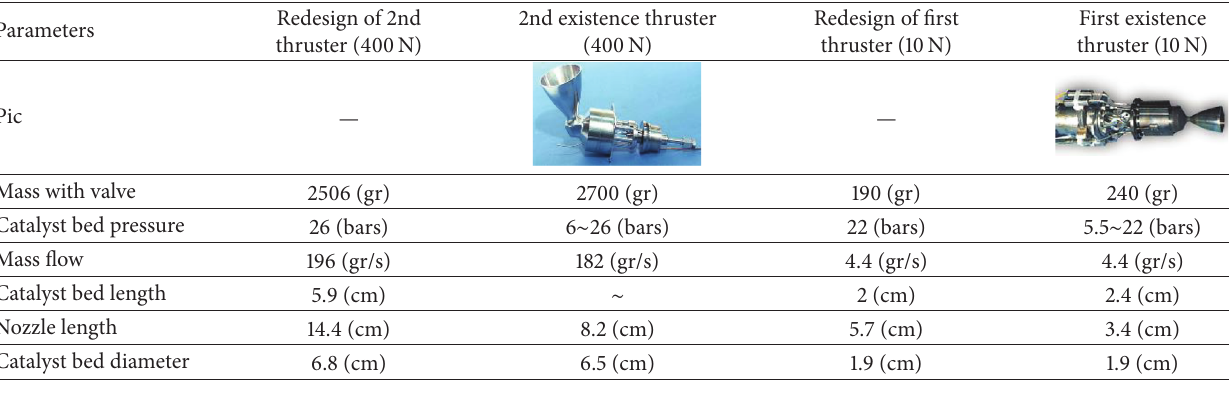
Table 3: Results of comparison of real thrusters and proposed design algorithm [10, 11].